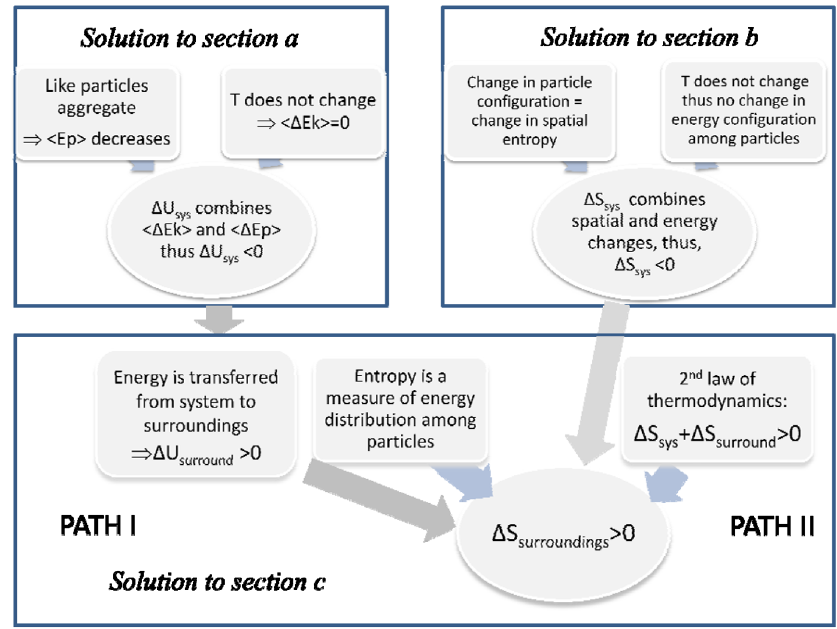
FIG. 2 (color online). Paths for proper solution of the phase separation